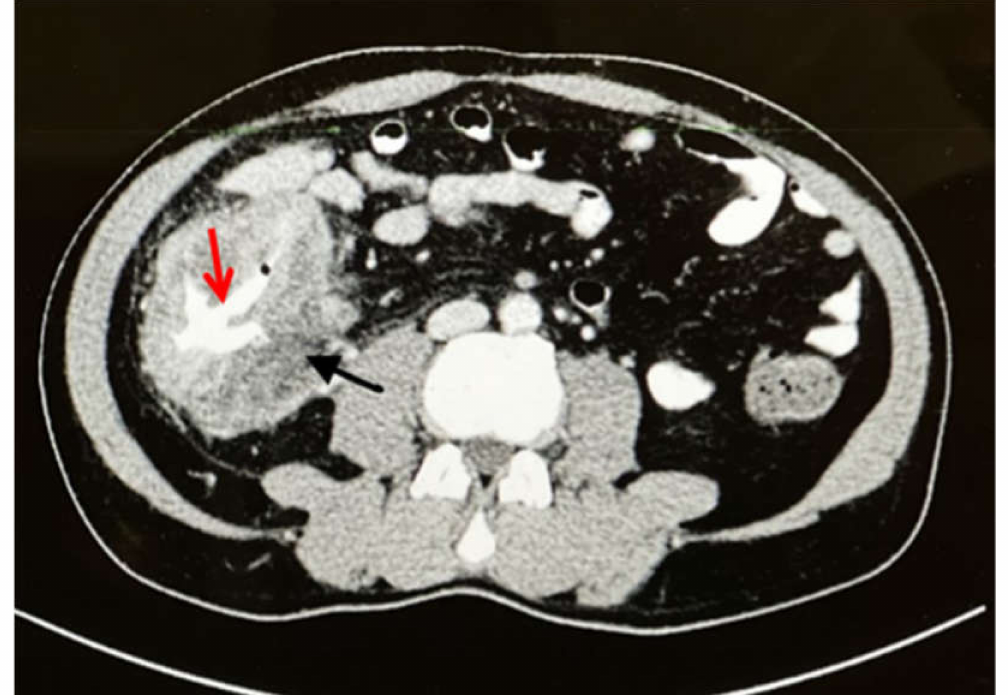
Figure 1. Axial CT with IV and oral contrast showed wall thickening affecting the cecum and ascending colon ( black arrow ) with lumen narrowing ( red arrow